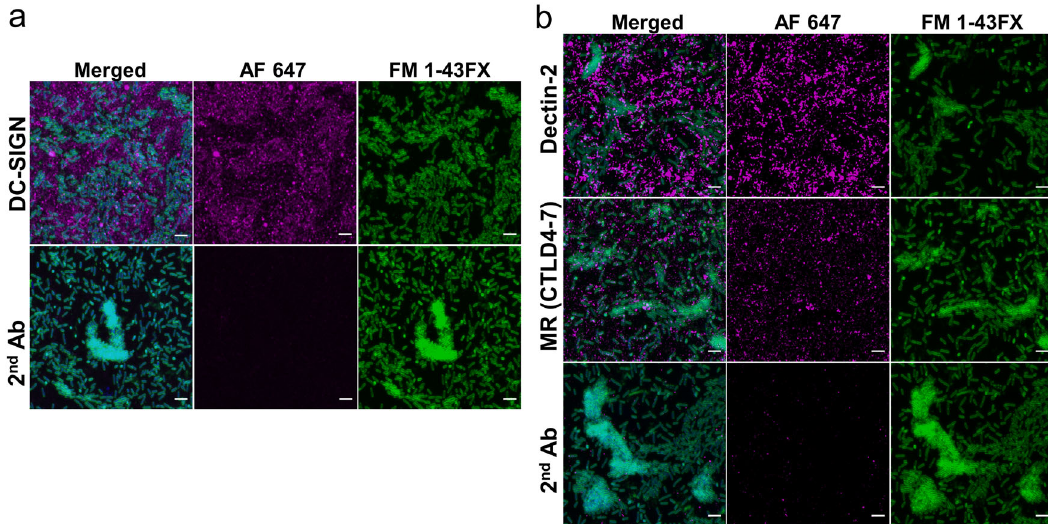
Fig. 2 Distribution of DC-SIGN, MR and Dectin-2 ligands in P. aeruginosa bio fi lms. PAO1 bio fi lms generated under fl ow conditions for 18 h as described in materials and methods were incubated with DC-SIGN, MR-CTLD4-7 and Dectin-2 Fc-chimeric proteins followed by anti-human Fc secondary antibody conjugated to Alexa 647 (magenta) and counterstained with DAPI (DNA, blue) and FM1-43FX (bacteria, green). Z-stacks were acquired for all samples using confocal microscopy. The fi gure shows 3D projections for the three receptors based on the initial detection of bacterial cells during image acquisition. The same settings for image acquisition and processing were maintained for test and control samples. Scale bar is 4 µm. Brightness and contrast settings in Fiji for DC-SIGN ( a ) and corresponding secondary antibody control (2nd Ab) (AF647 channel): minimum and maximum values 48 and 1497, respectively. For MR and Dectin-2 ( b ) and corresponding 2nd Ab control (AF647 channel): 330 for both. Settings for FM 1-43 FX and DAPI channels were the same in all instances. All slices for the three receptors are shown in Supplementary Fig.